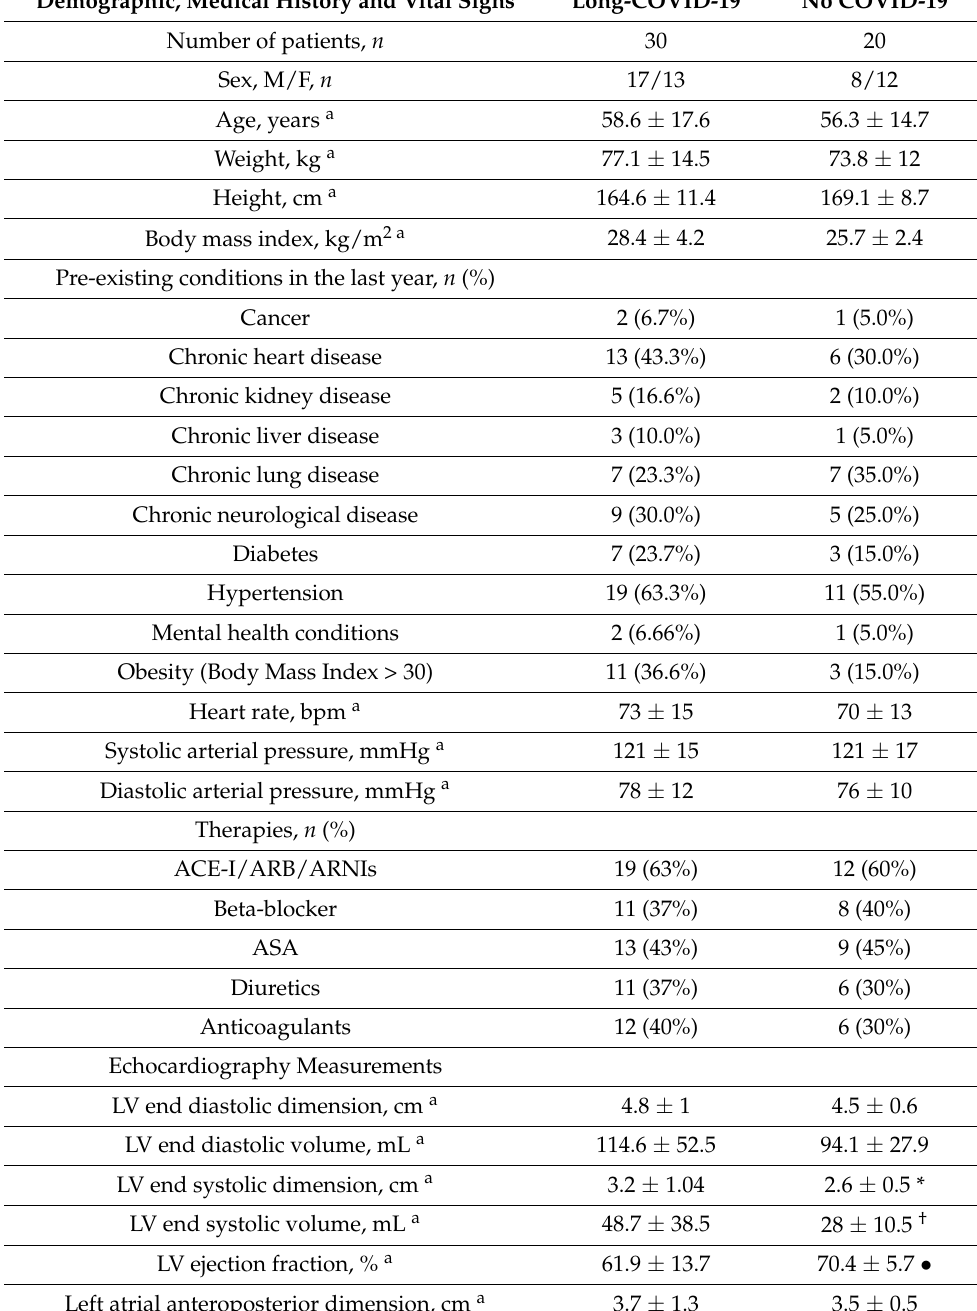
Table 2. Clinical characteristics and baseline values of the study population. Demographic, Medical History and Vital